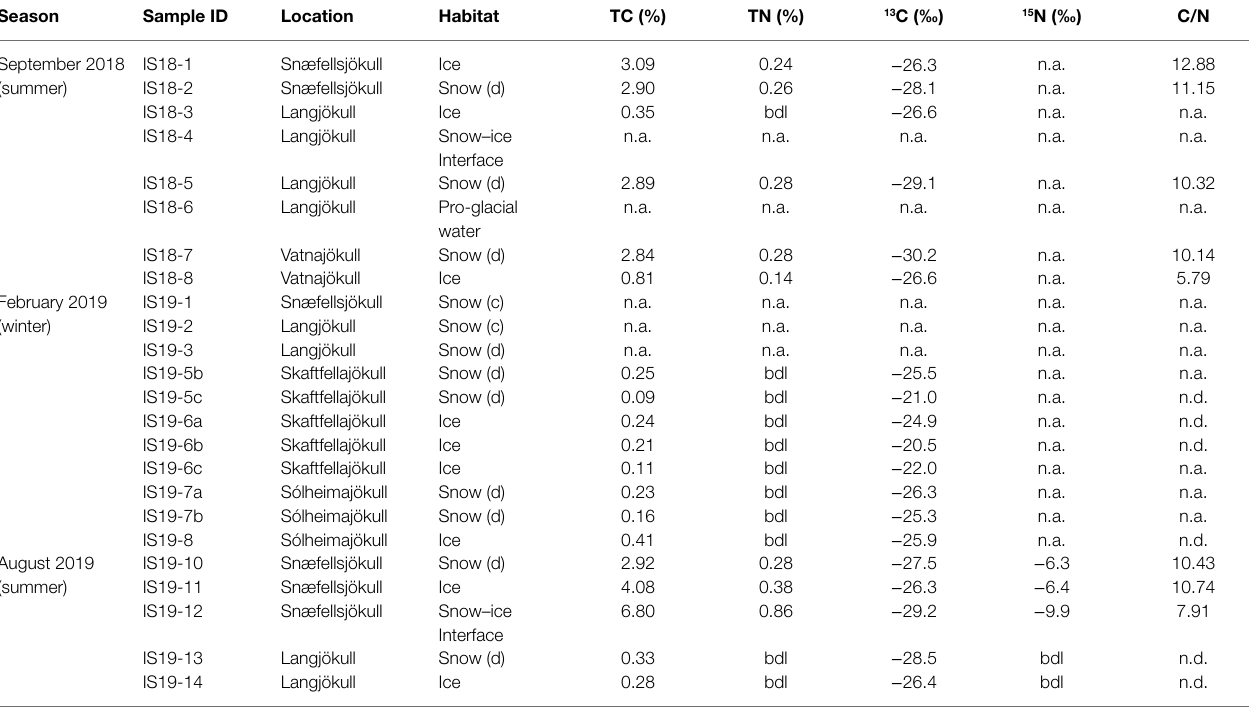
TABLE 3 | Bulk measurements of carbon, nitrogen and carbon stable isotopes based on dry weight. C/N ratios calculated from the TC and TN values.